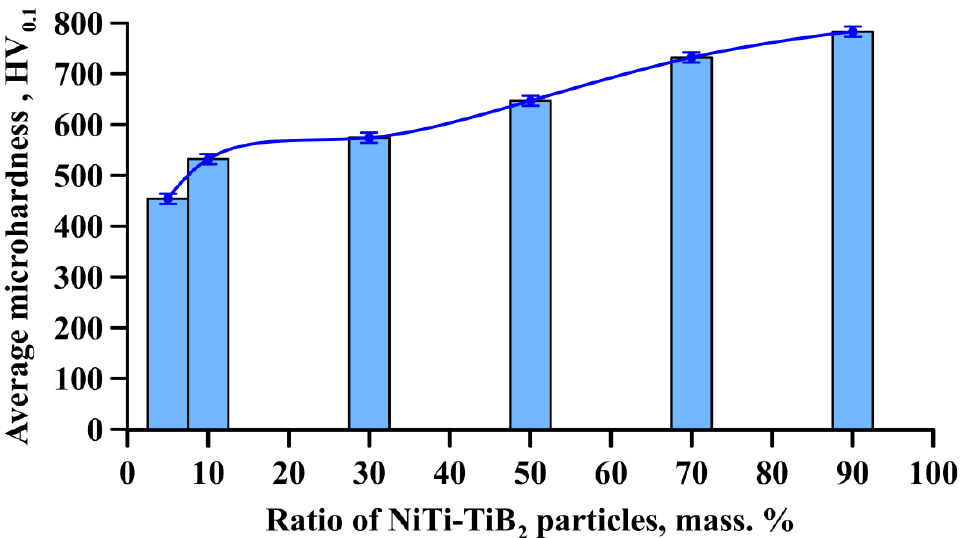
Figure 13. Average microhardness of samples obtained by direct laser deposition from an Inconel 625 – NiTi – TiB 2 powder mixture vs. the mass fraction of NiTi – TiB 2 particles.